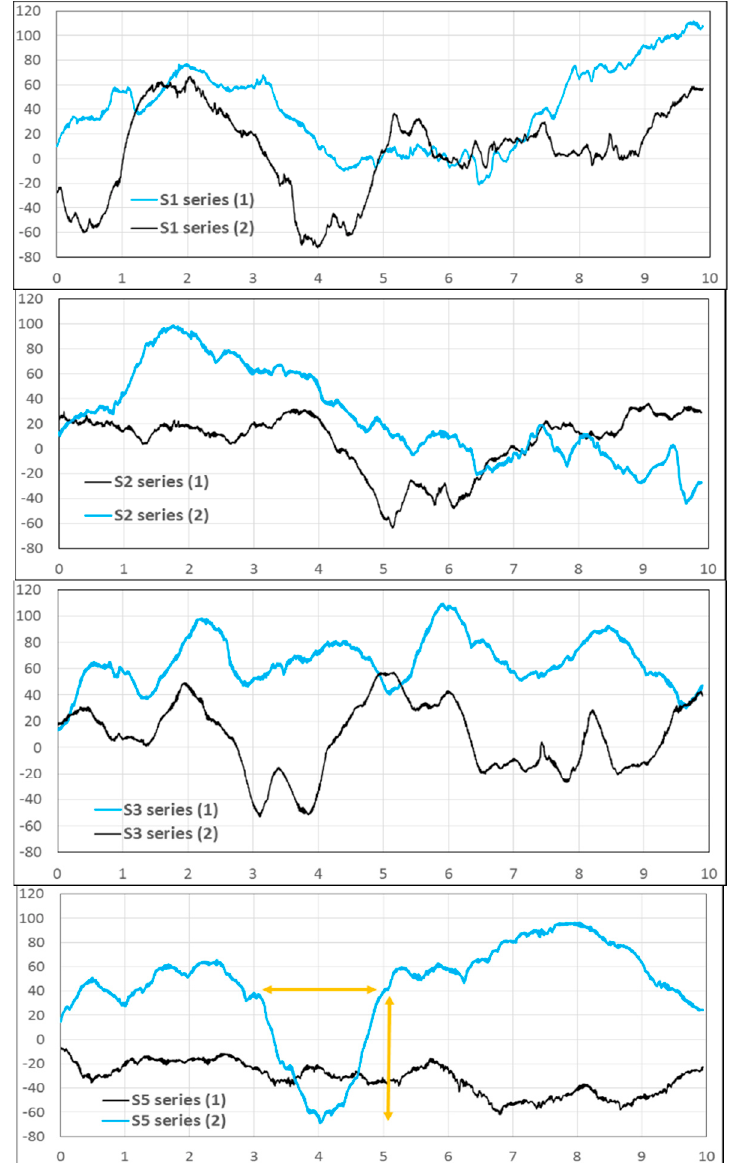
Figure 8. Variation of height of the profiles (Y-axis in µm) along the weld axis (X-axis in mm) in places of underfill for S1, S2, S3 and S5 series.